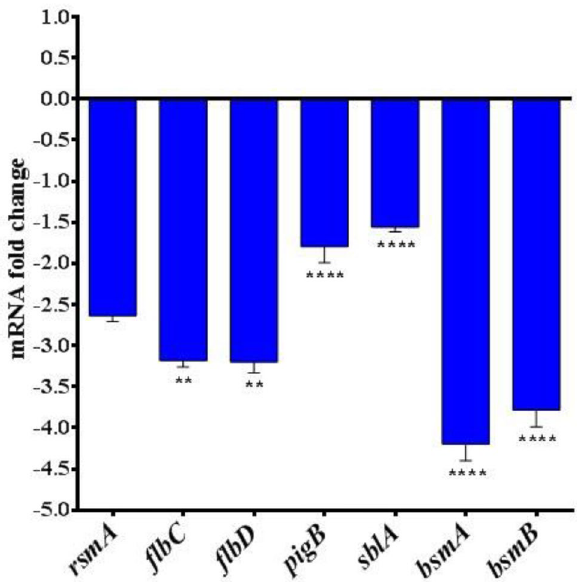
Figure 6. Downregulation of S. marcescens virulence genes.